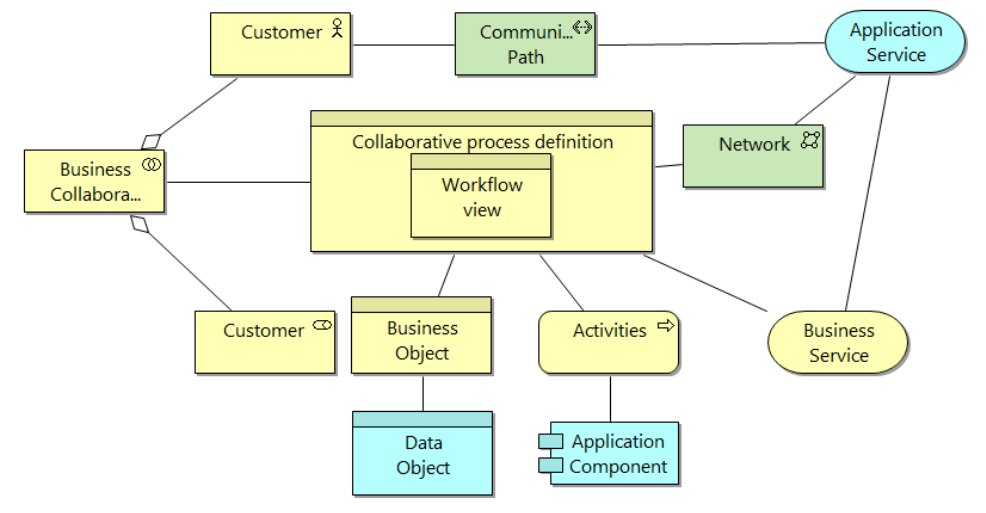
Figure 3 . Enterprise model elements for monitoring CBPs (the activity-flow